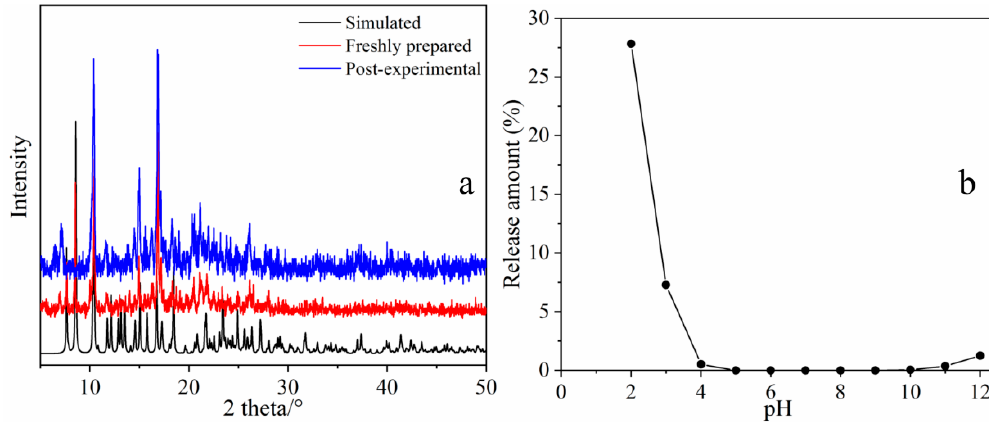
Figure 8. XRD spectra of MOF 1 ( a ) and the amount of Zn 2 + released by MOF 1 in different pH solutions ( b ).